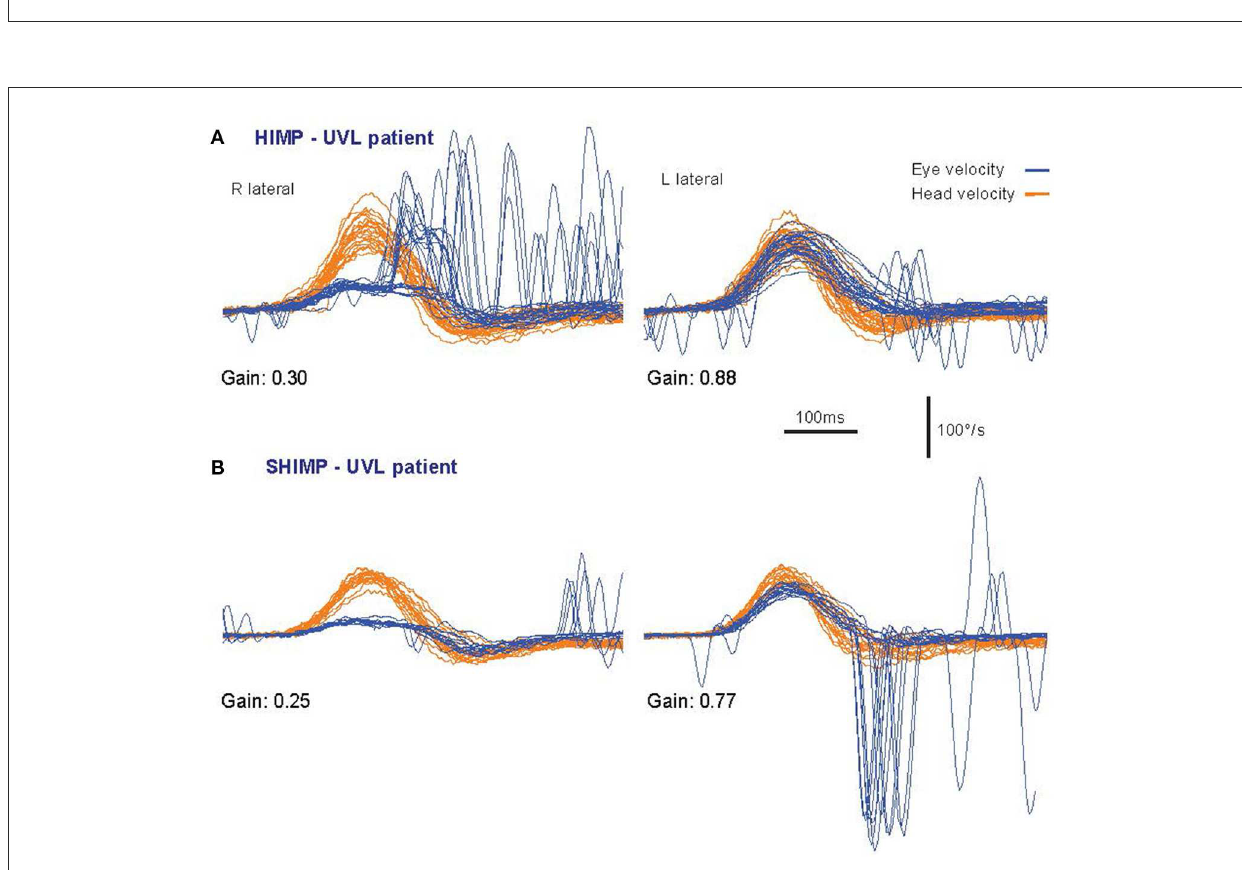
FIGURE2 Superimposed time series of the head velocity (orange) and eye velocity (blue—inverted for direct comparison) for repeated individual HIMPs and SHIMPs head impulses. The data are for the same patient with a right unilateral vestibular loss (UVL) during head turns to the affected (R) and healthy (L) side. For head turns to the affected side in both HIMPs and SHIMPS the patient’s eye velocity is less than head velocity, and so VOR gain is reduced. In (A) HIMPs there are covert and overt corrective saccades at the end of the head impulse. In (B) SHIMPs the same patient has no covert saccades during the head impulse to the affected side. For head turn to the healthy side there are many saccades at the end of the impulse (in an anticompensatory direction). Changing the instructions has little effect on VOR but dramatic effects on saccades [reproduced from Curthoys and Manzari (11) with